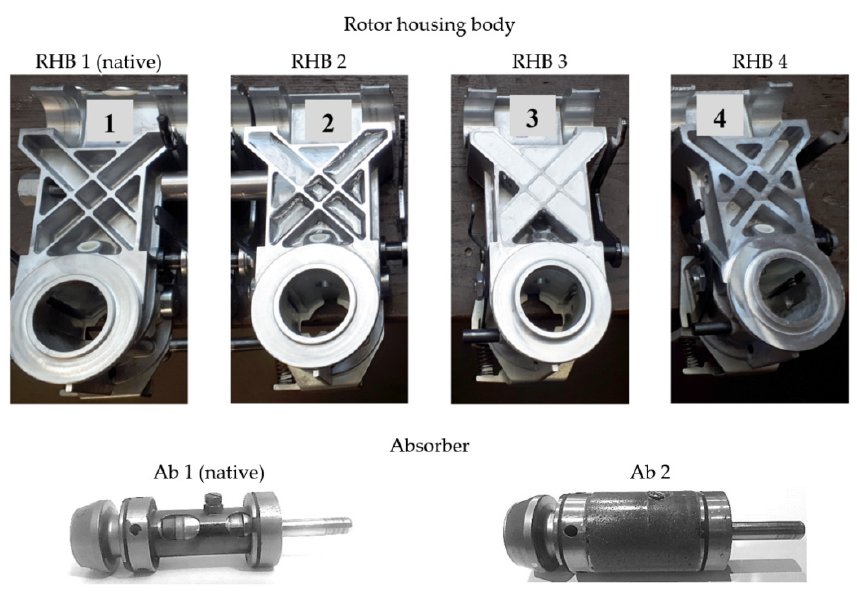
Figure 3. Rotor housing body (RHB) and absorber (Ab); native and the experimental re-designs. Table 1. Materials and design